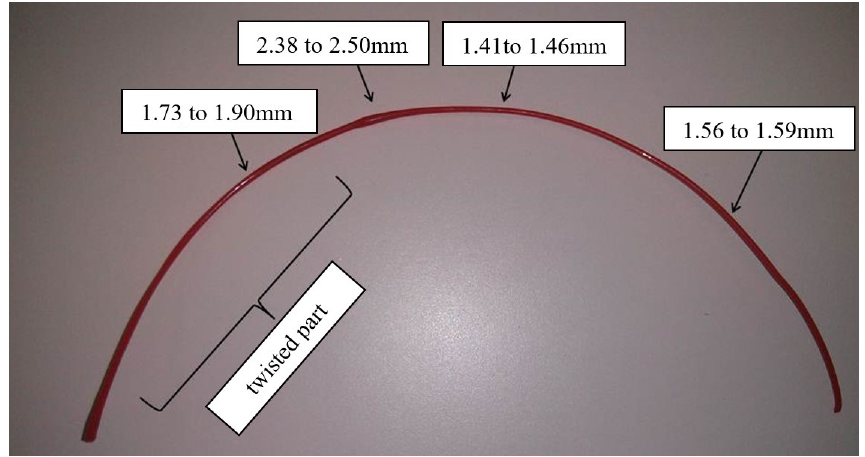
Figure 1. Defects in a filament